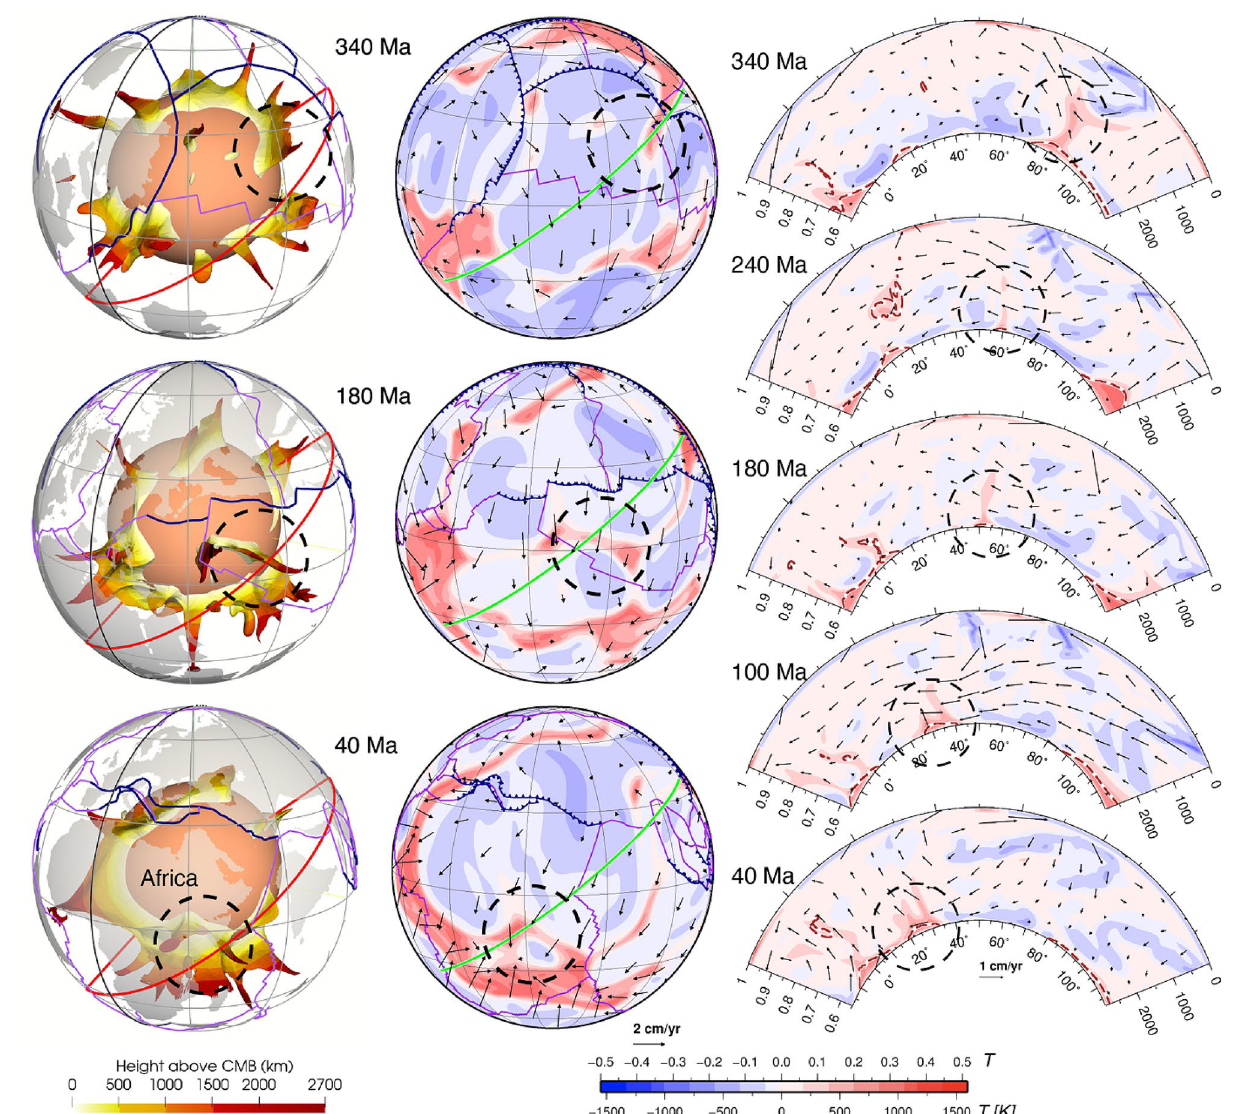
Figure 5. Example of material exchange between mantle structures from different hemispheres. The left panel shows the basal thermochemical structures (310 K hotter than layer average), the middle panel shows temperature anomaly at 2677 km depth, and the right panel shows temperature anomalies (temperature field with layer average removed) along a Northeast-trending cross-section (red and green lines respectively in the left and middle panels). A small thermochemical structure (marked by black dashed circles) is carved out from the superocean structure and subsequently merges with the (super)continent structure. The solid black meridian in the left panel denotes longitude 0º. In the right panel, the brown dashed contours indicate 50% concentration of dense material. The numbers on the left of the cross-section denote non-dimensional radius, and the numbers on the right of the cross-section denote depth (km). The numbers above the colour scale denote non- dimensional temperature, and the numbers below the colour scale denote dimensional temperature. This figure was created using the Generic Mapping Tools version 4.5.5 (https:// www. gener ic- mappi ng- tools. org/) 85